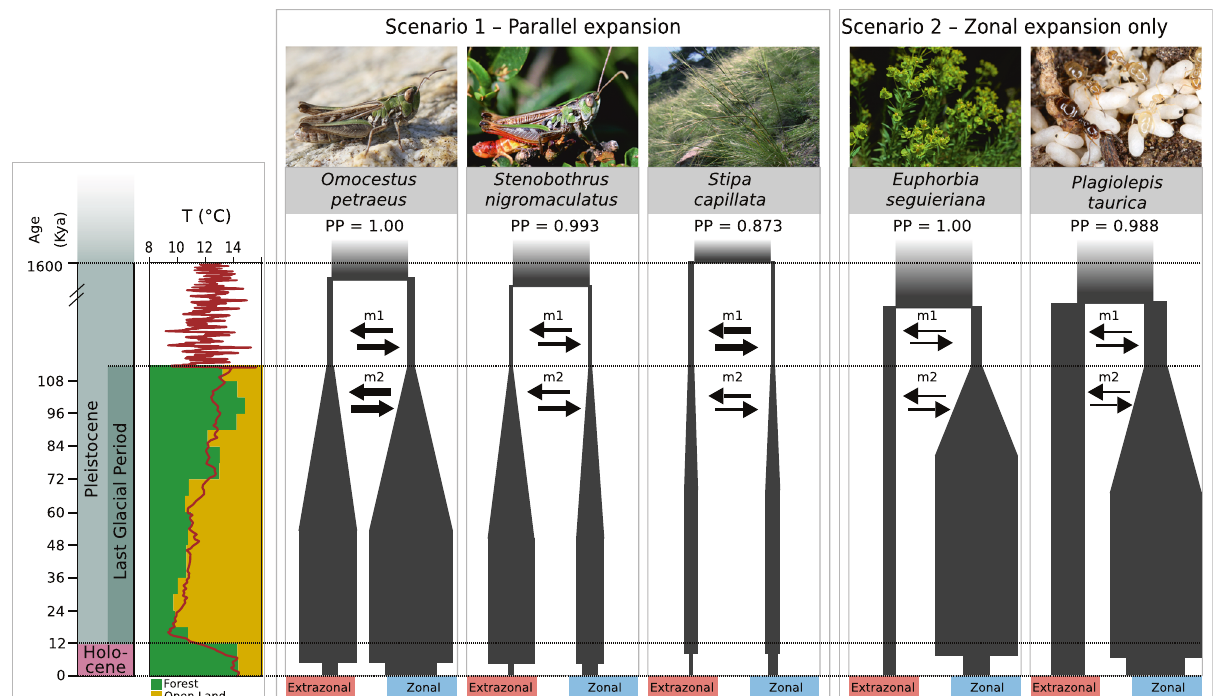
Fig. 4 Best fi tting demographic scenarios for the fi ve study species. Results showing selected demographic scenarios and associated parameters using convolutional neural network (CNN) modeling in fi ve species endemic to the European steppes. Each species comprises an extrazonal (red) and a zonal (blue) lineage. The left inset fi gure shows the time scale with geological epochs and temperature fl uctuations during the late Quaternary 39 : forest (green) and open land (yellow) pollen percentages throughout the last glacial period (LGP) are shown as bar plots; each bar represents 6000-year averages of the pollen percentages from fi ve major pollen records covering the entire last glacial – interglacial cycle (data from European Pollen Database and PANGEA database, details in Supplementary Information) 15 – 17,79,80 . In each demographic scenario, the timing of the initial split between the zonal and extrazonal lineages, the LGP expansion, and the Holocene contraction are proportional to the time scale. The fi ve species are assigned to their corresponding best- fi tting model. Posterior probabilities (PP) values supporting the best- fi tting model for each species are given above the demographic layout. In each layout, the diameters of branches and arrows are proportional to the inferred effective population sizes ( n ), and the inferred migration rates ( m ), respectively. For better visualization, branch diameters representing LGP population size were scaled down by 1/10 compared to pre- and post-LGP population sizes. Terminology for estimated parameters in Fig. 1; more detailed results in Supplementary Table